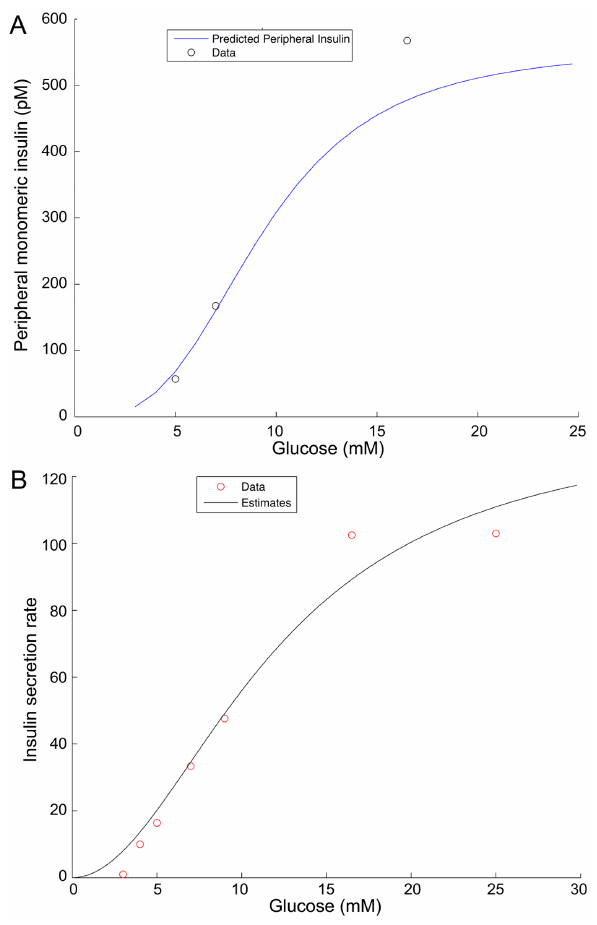
Figure 2. Validation of the model insulin secretion rate function. ( A ) The model output plotted against dose response data from Polonsky et al (1988) for comparison. ( B ) Insulin secretion rate data were use to estimate an insulin secretion rate response function. Model profiles were then created with different doses of clamped glucose (mM) and compared to peripheral insulin values (pM) at equilibrium at those glucose doses (mM).